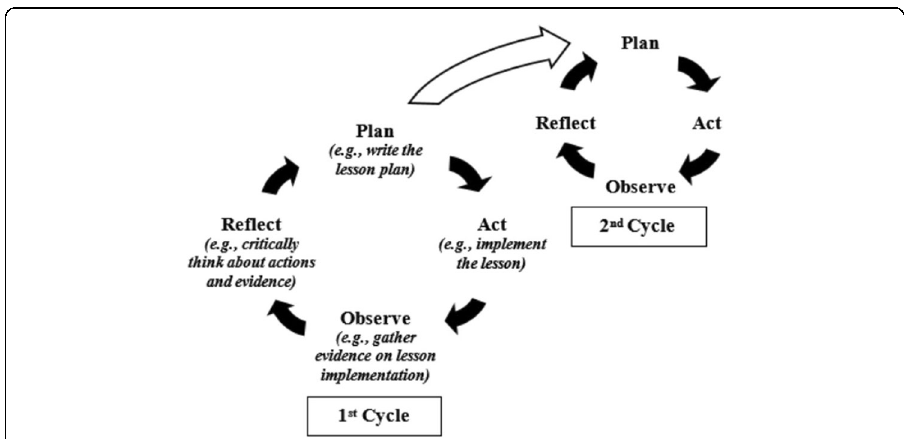
Fig. 1 Flow chart of trial